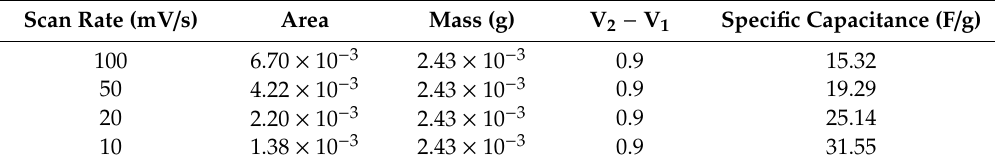
Figure 11. CV curve of the EDLC measured for the CSNZG3 sample at different sweep rates in the potential range of 0 to 0.9 V. Table 5. Specific capacitance ( C p ) value of the CSNZG3 film at the various scan rates of 100, 50, 20, and 10 mV/s.